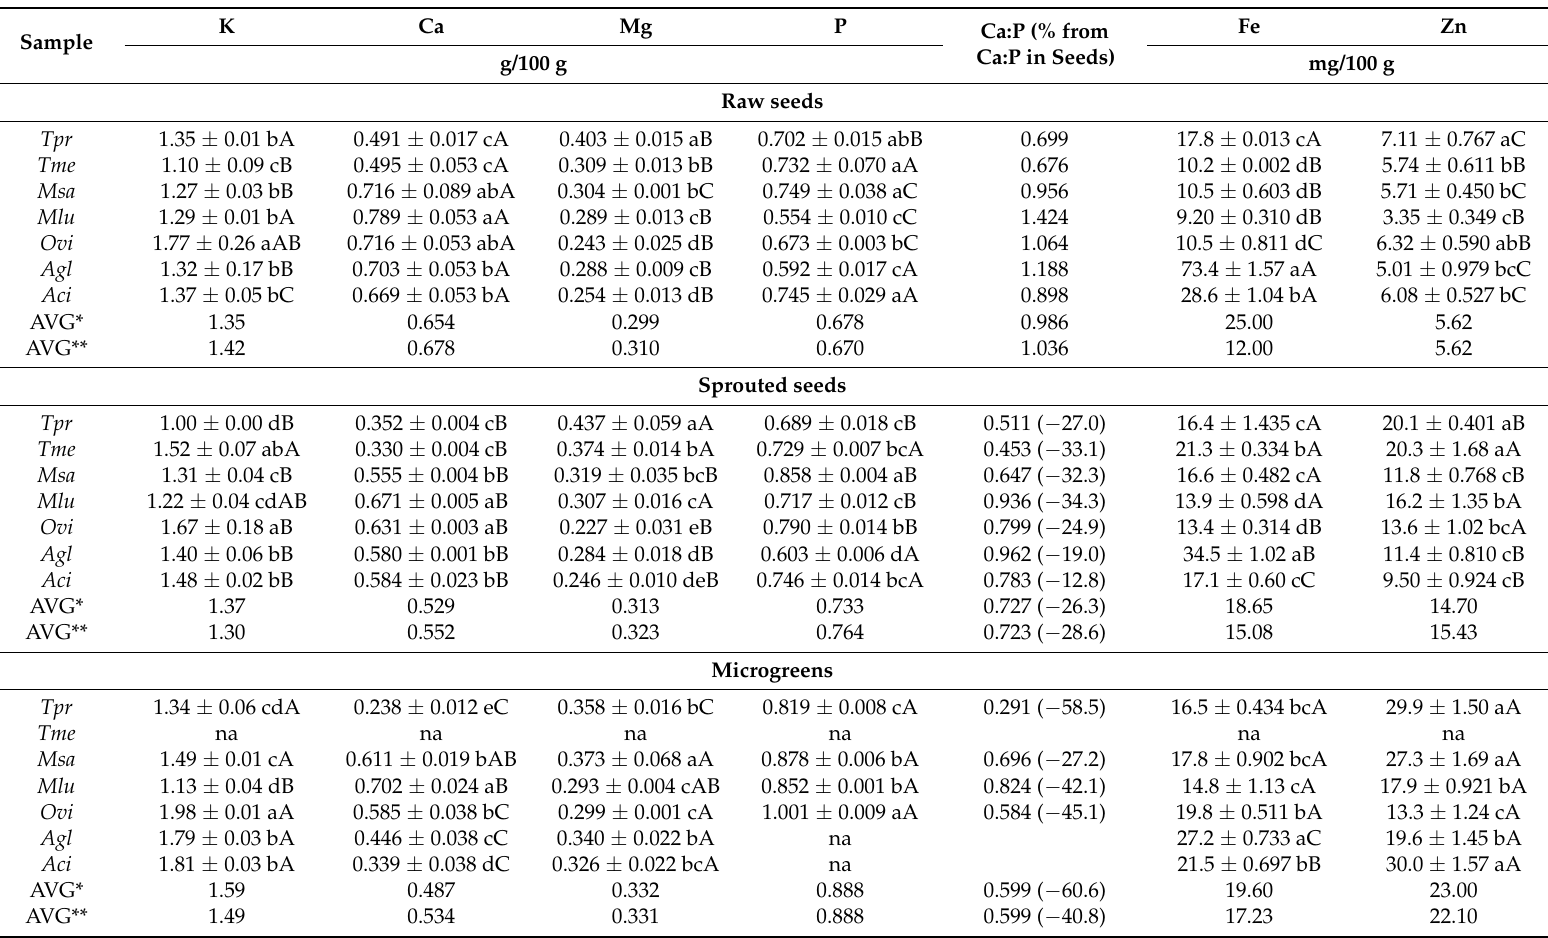
Table 2. The variation of mineral composition in the chain raw seeds-sprouted seeds-microgreens of perennial legumes (mean ± SD).